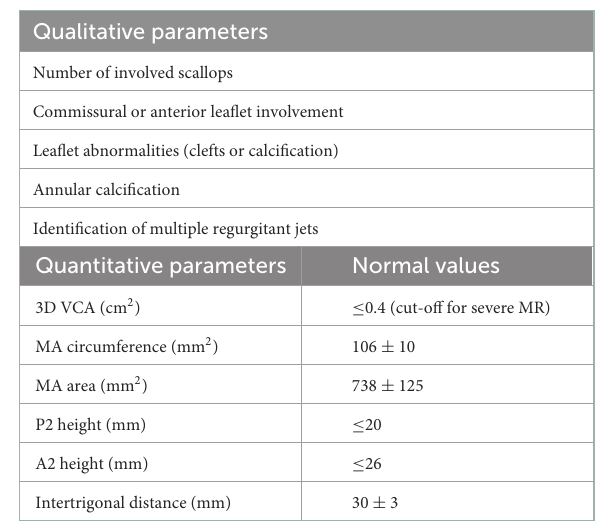
TABLE 2 Pre-operative checklist of 3D echocardiographic parameters for planning MVP